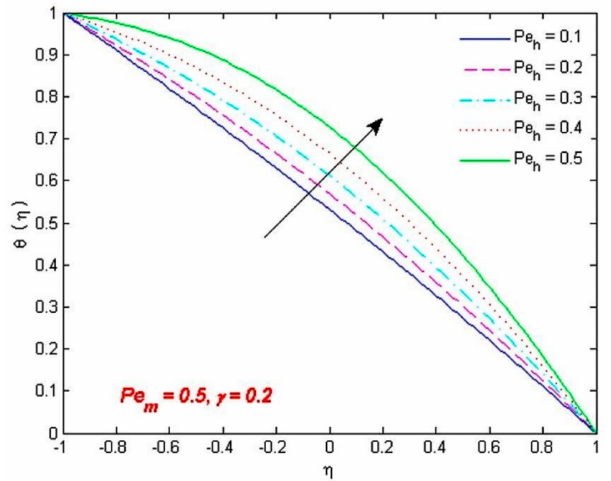
Figure 6. Change in temperature for various values of Peclet number for the diffusion of heat Pe h .